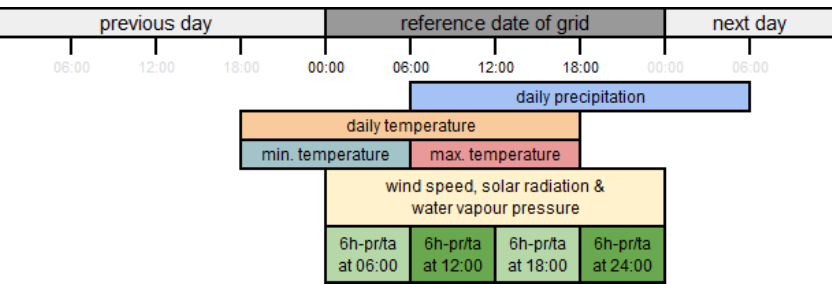
Figure 5. Aggregation, i.e. reference period of the EMO-5 grids per